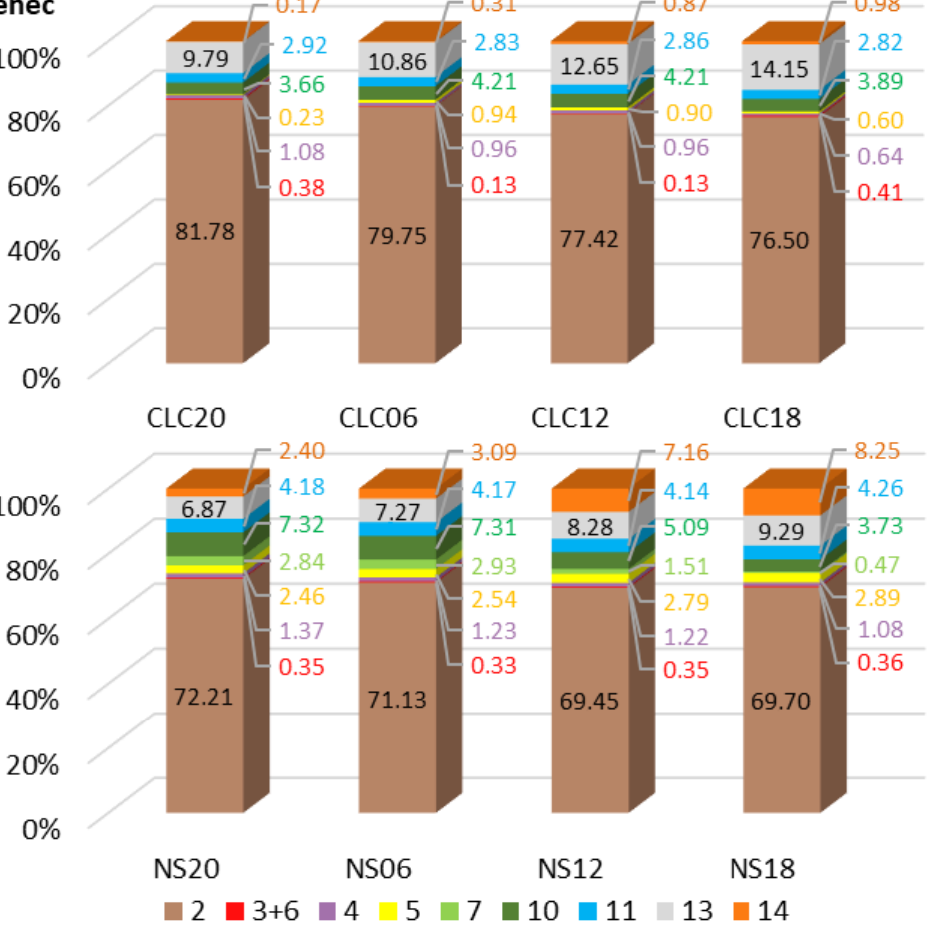
Figure 3. Development of relative LU values for the counties of Senec according to recorded national statistics (NS) and CLC3 data in 2000, 2006, 2012, and 2018. LU codes according to NS: 2 arable land, 3 hop fields, 4 vineyards, 5 gardens, 6 orchards, 7 permanent grassland, 10 forest land, 11 water bodies, 13 built-up areas and courtyards, and 14 other